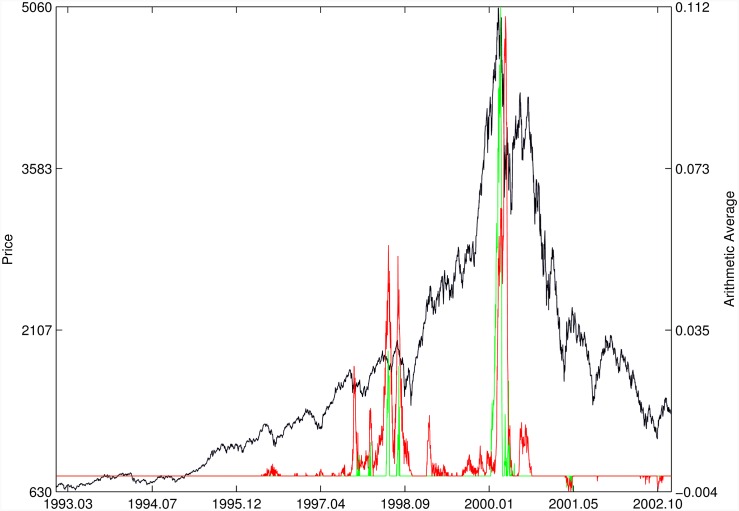
Nasdaq Composite Index 2000.Same as Fig 10.